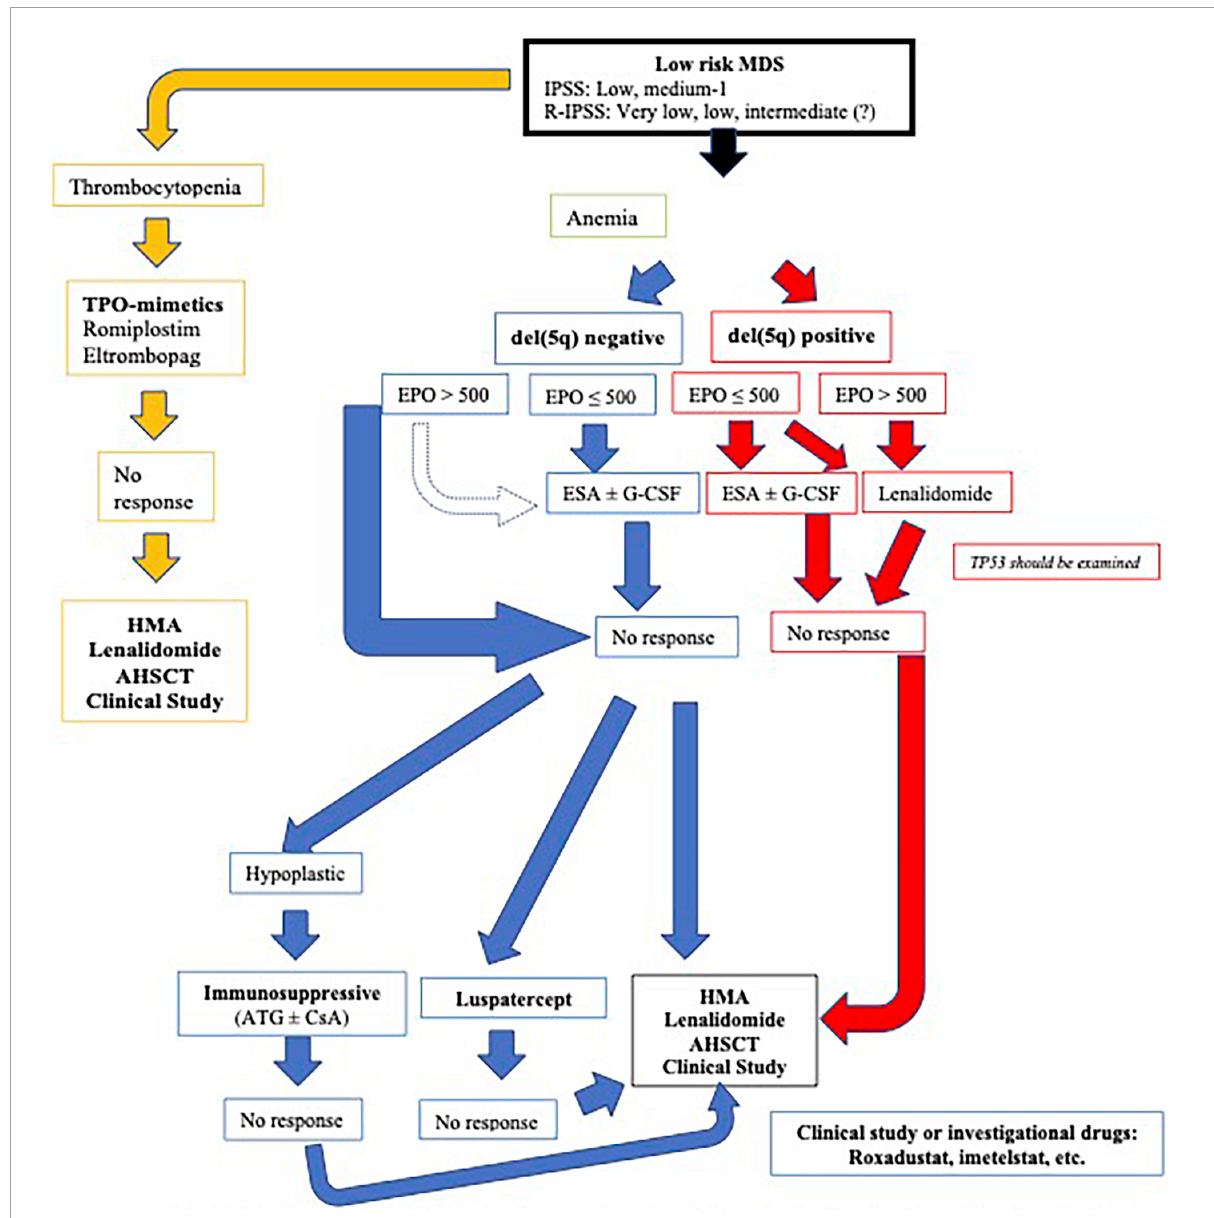
FIGURE2 Current treatment approaches in low-risk myelodysplastic syndromes (MDS) (19, 20). MDS, myclodysplastic syndrome ; IPSS, International Prognostic Scoring System; R-IPSS, Revised International Prognostic Scoring System; TPO, thrombopoietin; EPO, erythropoietin; ESA, erythropoiesis stimulating agents; G-CSF, granulocyte colony stimulating factor; HMA, hypomethylating agents; AHSCT, allogeneic hematopoietic stem cell transplantation; ATG, antithymocyte globulin; CsA,